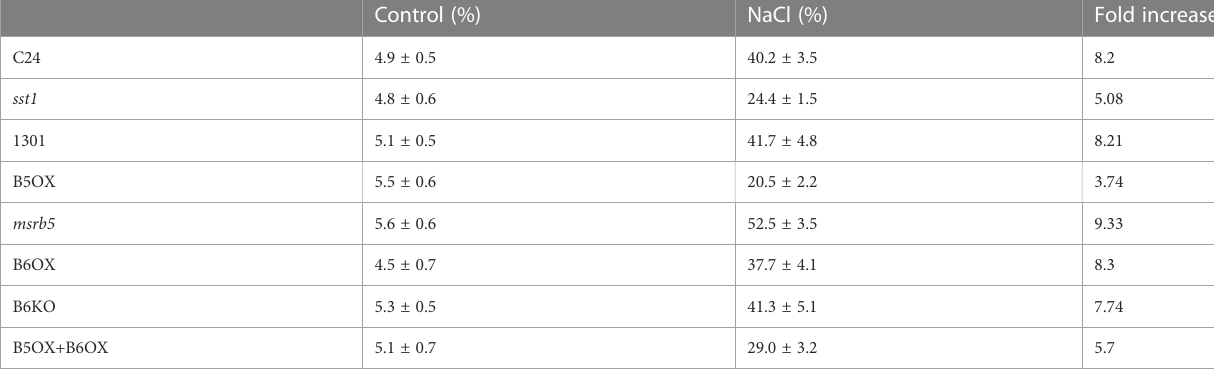
TABLE 1 Determination of oxidized methionine content in overexpressing and wild-type lines under salt treatment.